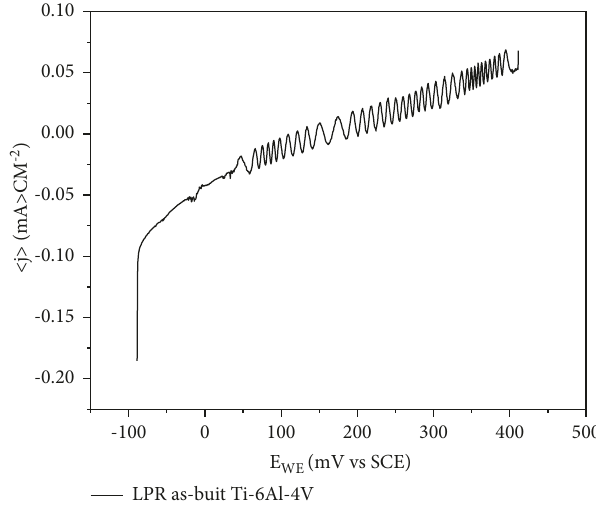
Figure 2: LPR of as-built Ti-6Al-4V in